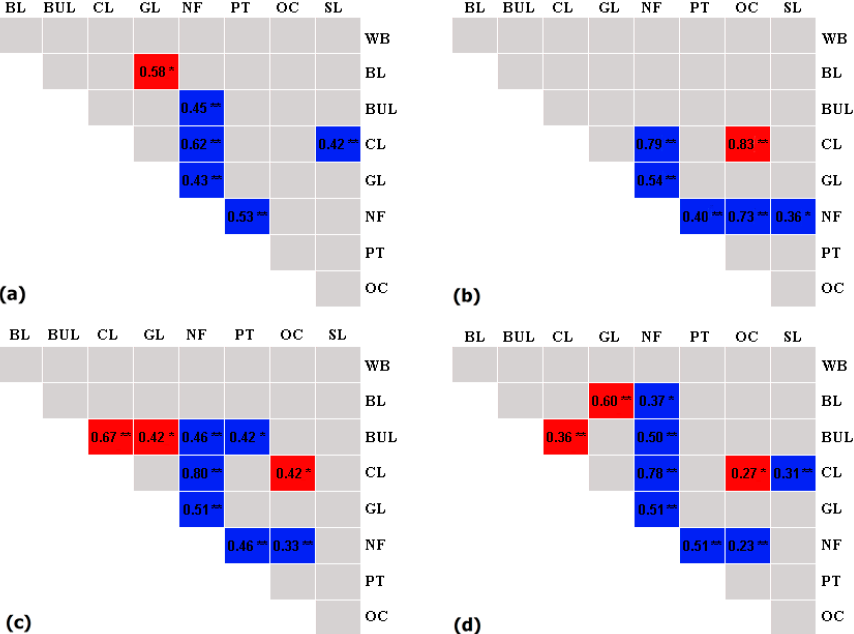
Figure 7. Pairwise relationships between areas of land use types at the watersheds scale in 2013. ( a ) The relationship of land use types in SY, ( b ) the relationship of land use types in ZS, ( c ) the relationship of land use types in SC, and ( d ) the relationship of land use types. Blue represents negative relationships and red represents positive relationships. White represents relationships with no established inter-relationship. The data in the frame represents the correlation coefficients between land use types. * Means that p less than 0.05; ** means that p less than 0.01. BL refers to bare land, BUL to built-up land, CL to cropland, GL to grassland, NF to natural forests, PT to plantations, OC to orchard, SL to shrubland, and WB to waterbodies.